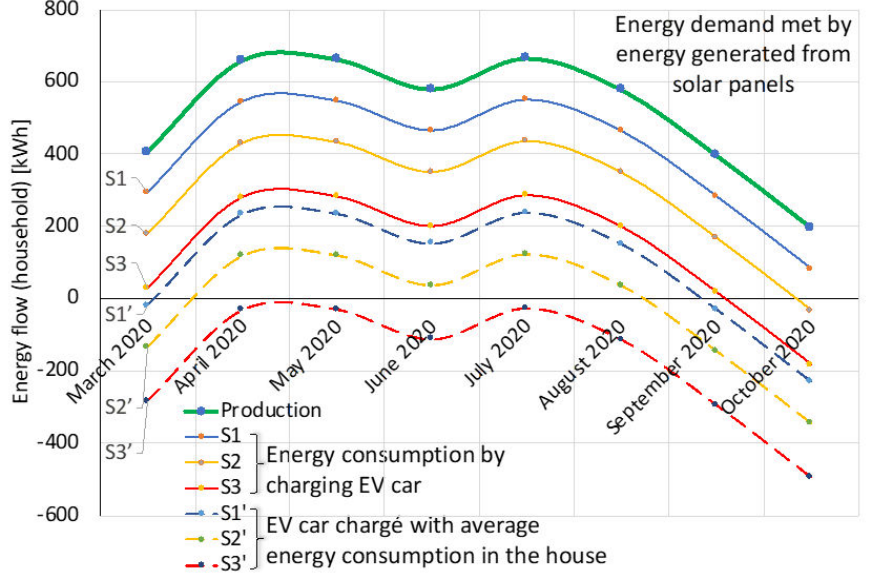
Figure 16. Energy balance of the presented scenarios of driving an electric vehicle in relation to the energy produced and consumed by a household with a 4.48 kW photovoltaic